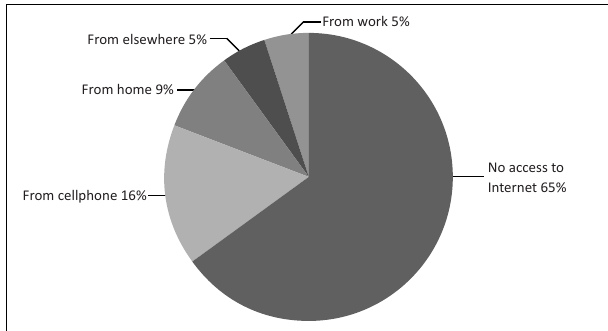
FIGURE 2: Internet